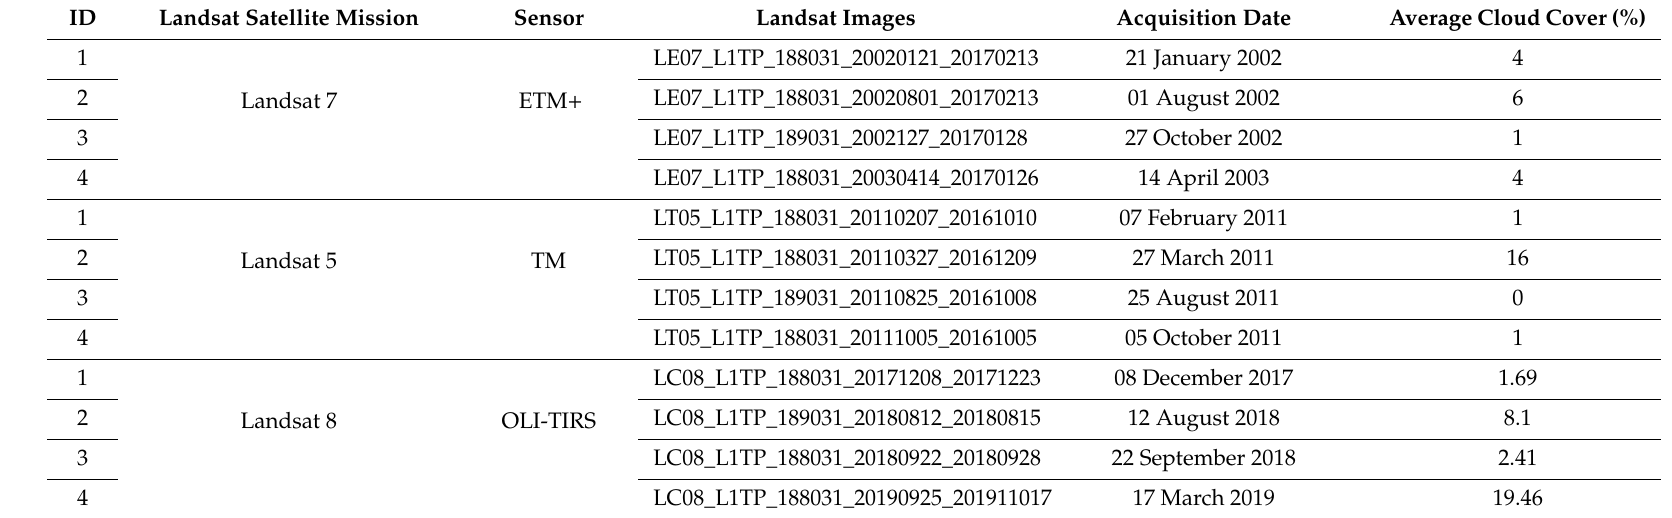
Table 3. Selected Landsat data description. ETM + , enhanced thematic mapper; TM, thematic mapper; OLI-TIRS, operational land imager - thermal